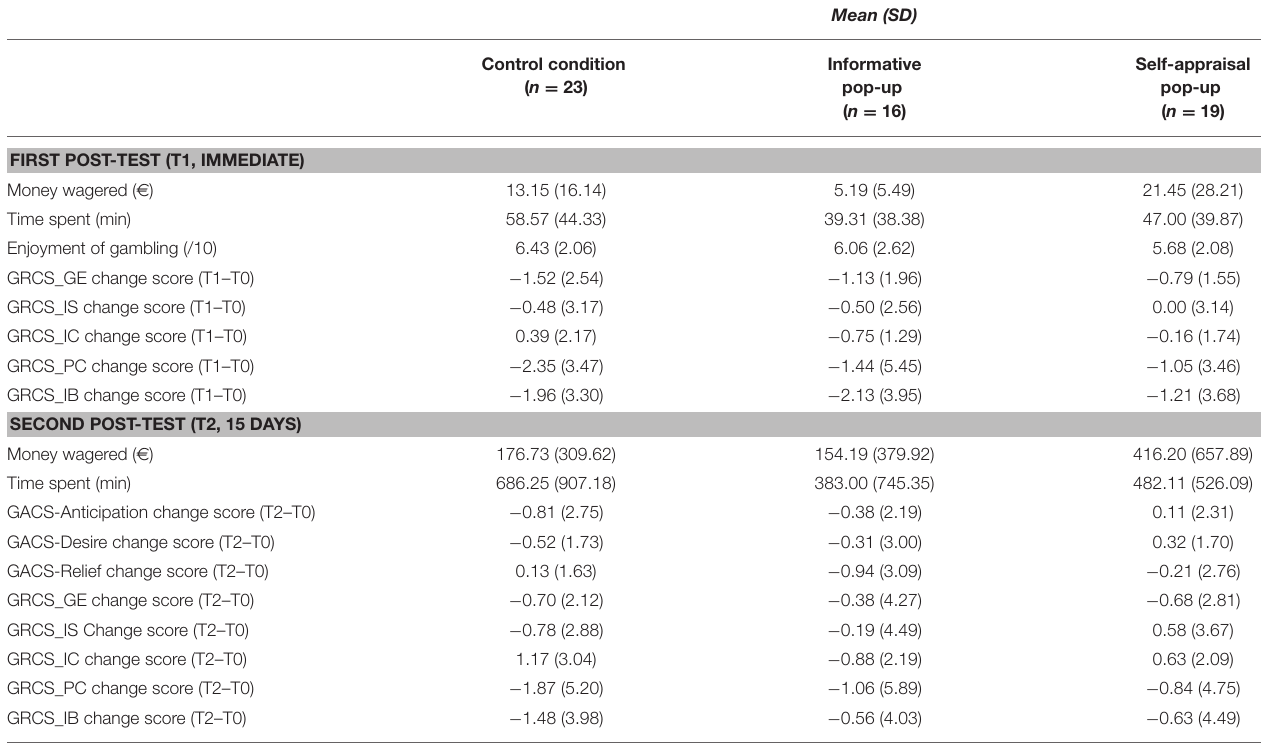
TABLE 1 | Description of the variables of interest according to the conditions ( n